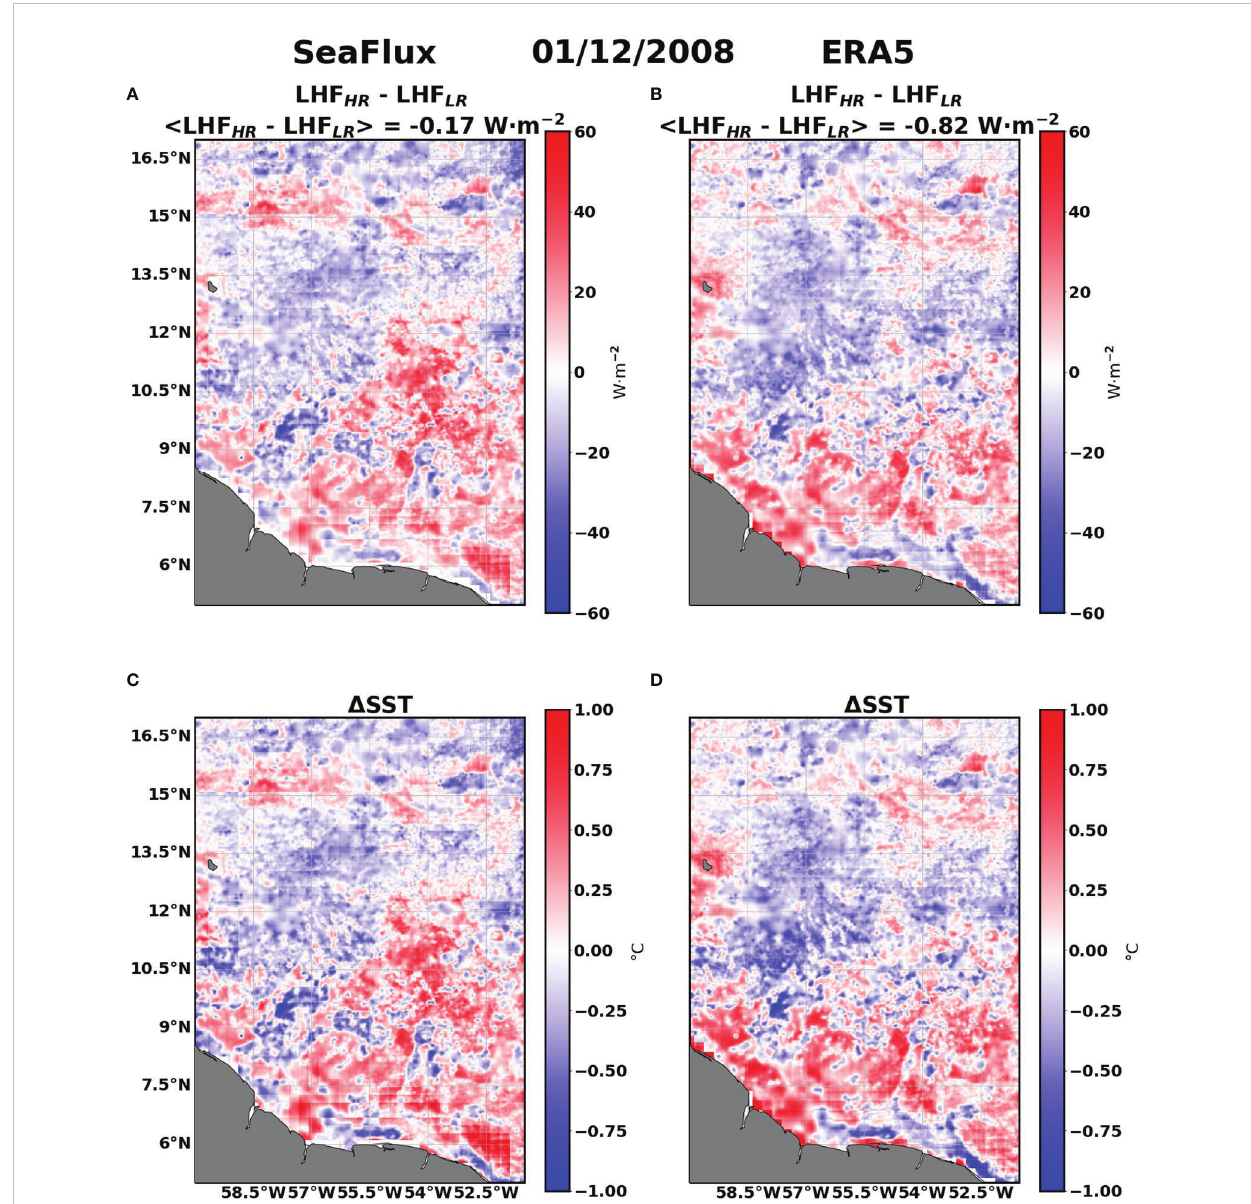
FIGURE 6 01/12/2008 values of (A, B) difference between the reconstructed LHF from the downscaled near-surface variables and SST (LHF HR ) and the LHF obtained from the raw SeaFlux/ERA5 variables (LHF LR ). (C, D) represent the 01/12/2008 values of the SST correction ( D SST) for SeaFlux/ERA5. Angle brackets in the titles of the fi gures represent the area-weighted mean values of the variables represented in the corresponding